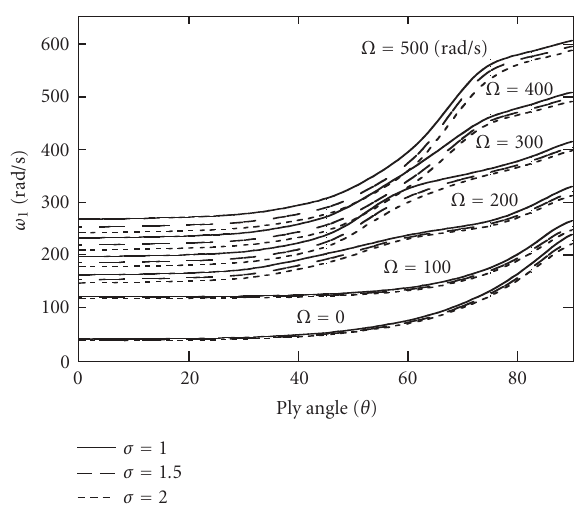
Figure 4: Variation of the first coupled flapping-lagging frequency versus plyangle for selected rotating speeds Ω (rad/s), and three dif- ferent taper ratios ( γ = β =